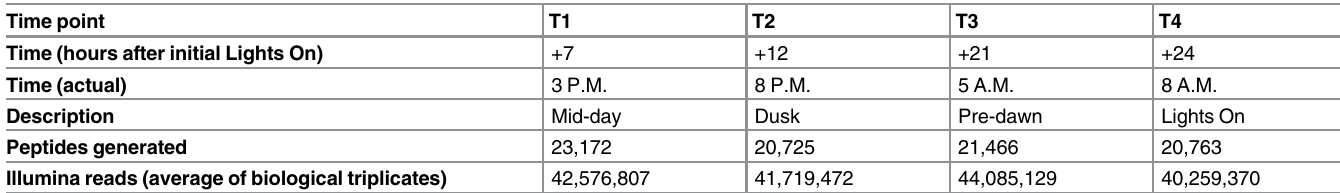
Table 1. Sample collection time points, RNA-Seq reads and proteomic spectra measured. Note that 14 hours after the initial lights on (8:00 a.m.) the lights turned off (i.e. turned off at 10 p.m.) for a 10 hour dark period that ended exactly at 24 hours past the initial lights on (i.e.,